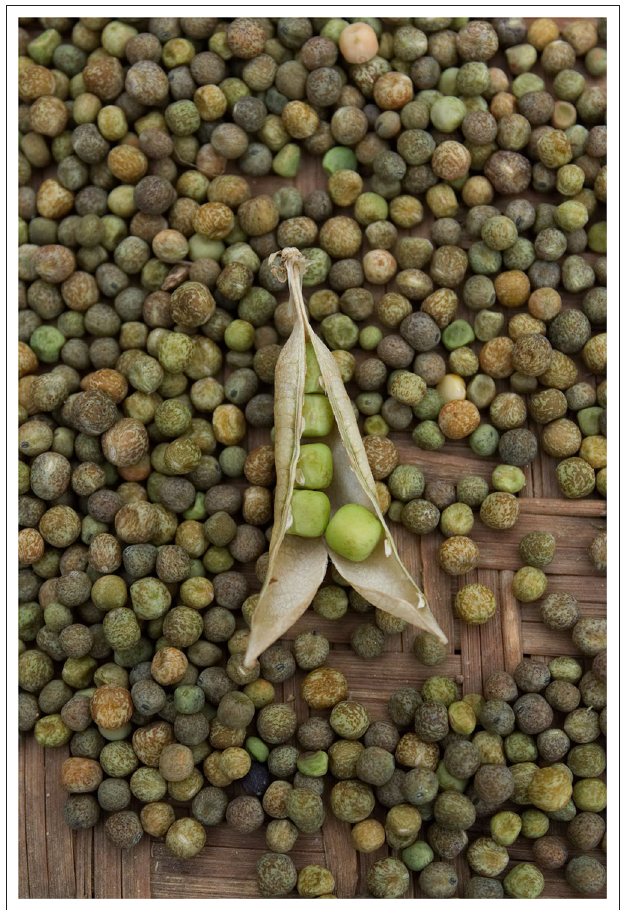
FIGURE 5 | Kalaun , a local pea variety with ritual significance in the community.